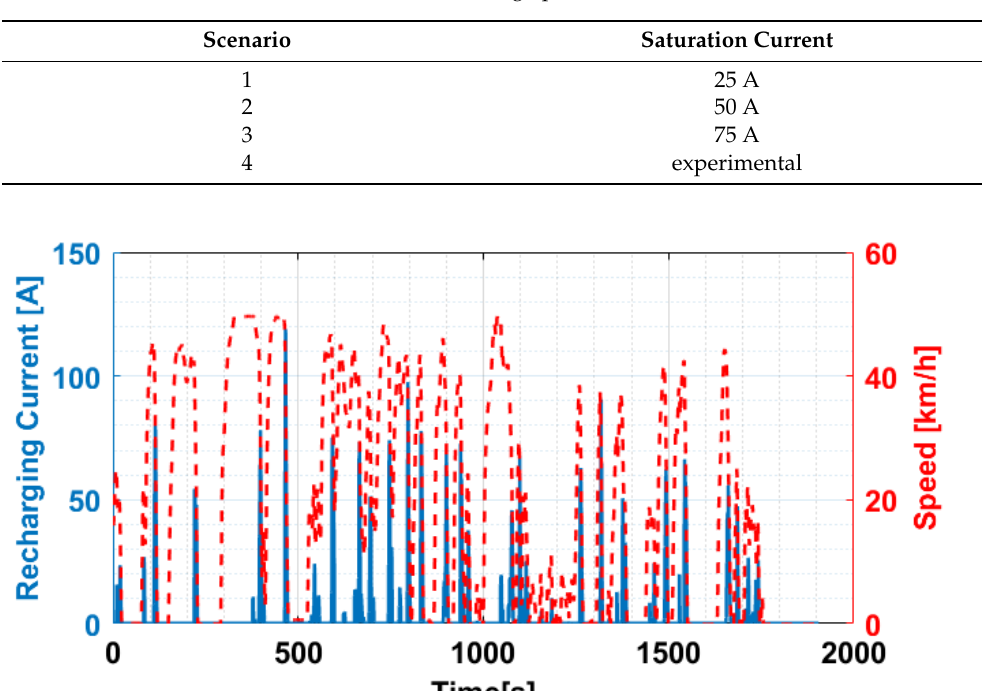
Table 6. Saturation currents considered in the tuning operation.